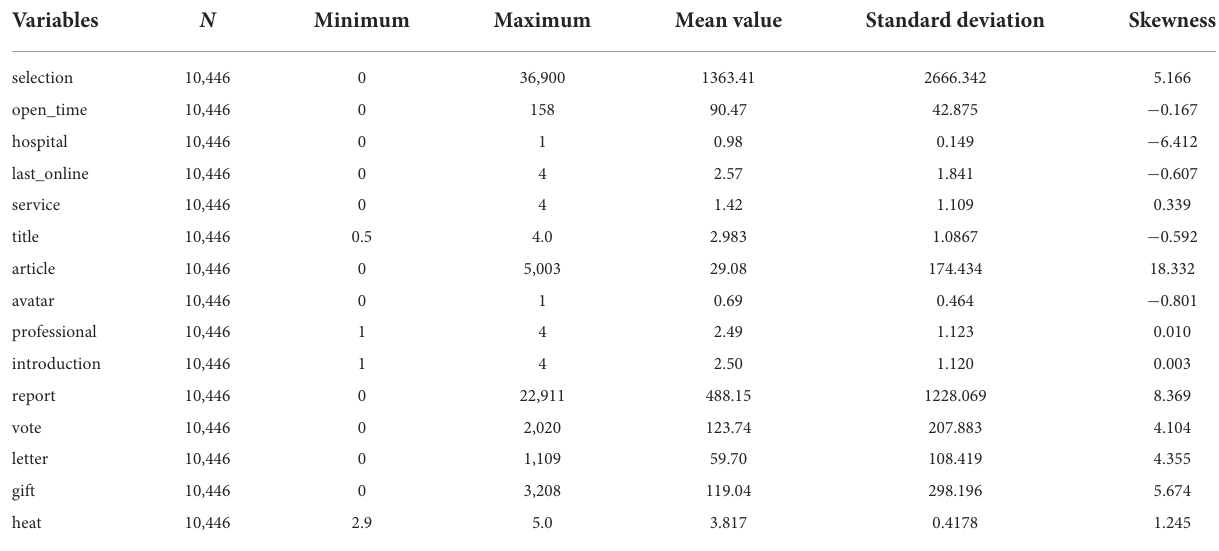
TABLE 2 Descriptive statistics of